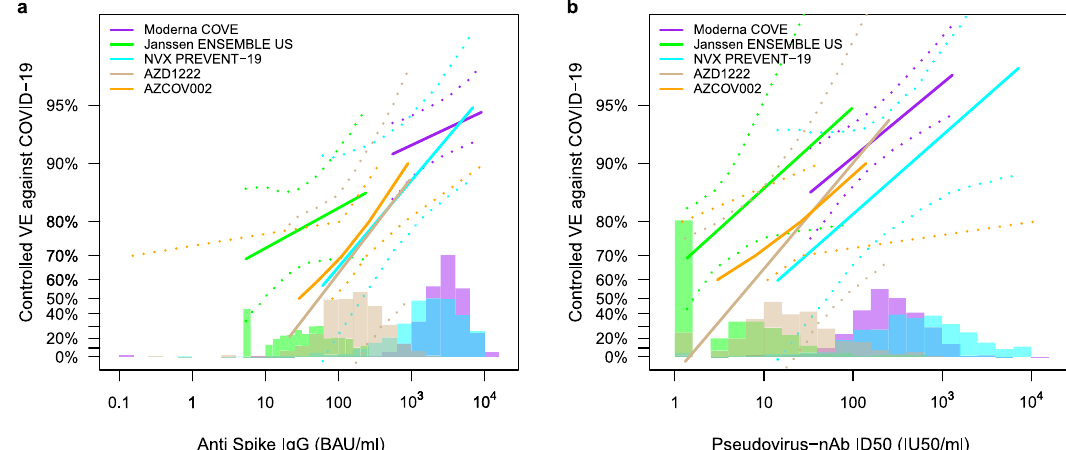
Fig. 6 Vaccine ef fi cacy (solid lines) in baseline SARS-CoV-2 negative participants by post-vaccination antibody marker level in fi ve randomized, placebo-controlled COVID-19 vaccine ef fi cacy trials. Vaccine ef fi cacy was estimated using the marginalized Cox proportional hazards implementation of Gilbert et al. 28 . Vaccine ef fi cacy (VE) estimates are shown by ( a ) anti-spike IgG concentration [D57 in COVE, D29 in ENSEMBLE-United States sites (ENSEMBLE-US), D35 in PREVENT-19, D57 in COV002] or ( b ) pseudovirus (PsV)-nAb ID50 titer (D57 in COVE, D29 in ENSEMBLE-US, D57 in AZD1222, D35 in PREVENT-19, D56 in COV002). The dashed lines indicate bootstrap point-wise 95% con fi dence intervals. The follow-up periods for the VE assessment were: COVE (doses D1, D29), 7 to 100 days post D57; ENSEMBLE-US (one dose, D1), 1 to 53 days post D29; PREVENT-19 (doses D0, D21), 7 – 59 days post D35; AZD1222 (doses D1, D29), 7 to 92 days post D57; COV002 (doses D1, D29; 7 to ~150 days post D57). The histograms are an estimate of antibody marker density in baseline SARS-CoV-2 negative vaccine recipients. Curves are plotted over the following antibody marker ranges: ( a ) COVE: 2.5th percentile to 97.5th percentile of marker, ENSEMBLE-US: 2.5th percentile to 97.5th percentile, PREVENT-19: 2.5th percentile to 97.5th percentile, COV002: 29 to 899 BAU/ml; ( b ) COVE: 10 IU50/ml to 97.5th percentile of marker, ENSEMBLE-US: 2.5th percentile to 97.5th percentile, PREVENT-19: 2.5th percentile to 97.5th percentile, AZD1222: 2.5th percentile to 97.5th percentile, COV002: 3 to 140 IU50/ml. Baseline covariates adjusted for were: COVE: baseline risk score, comorbidity status, and Community of color status; ENSEMBLE-US, baseline risk score; PREVENT-19: baseline risk score; AZD1222: age, baseline risk score; COV002: baseline risk